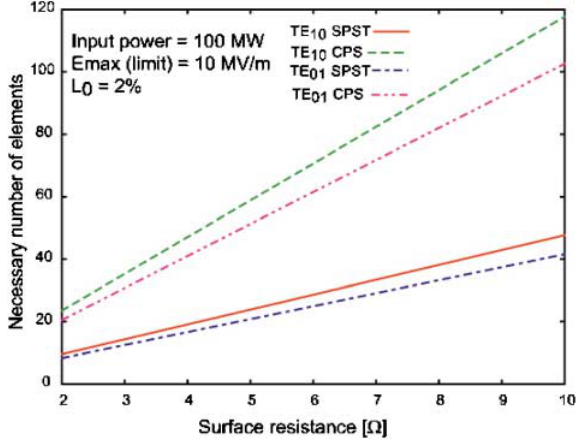
FIG. 7. (Color) Surface resistance versus necessary number of elements.